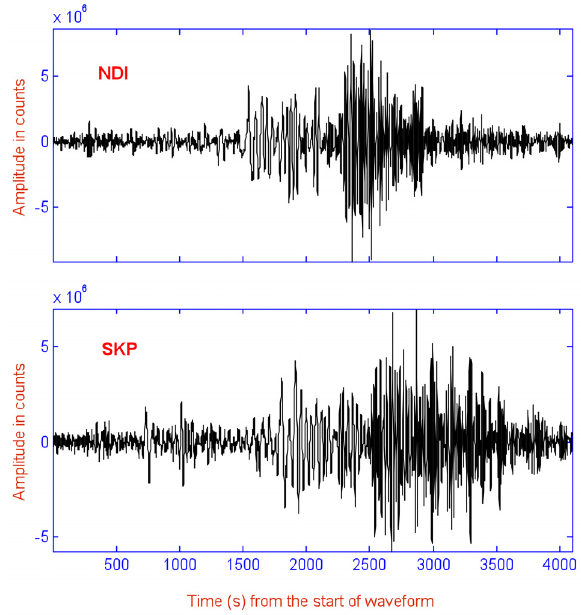
Figure 2. Vertical components of seismograms of NDI and SKP from event 2 (Table 2). The start time of both the waveform is 03h 04m 08.82s. The phase velocities obtained through cross correlation of this pair of seismograms are shown in Figure 3.